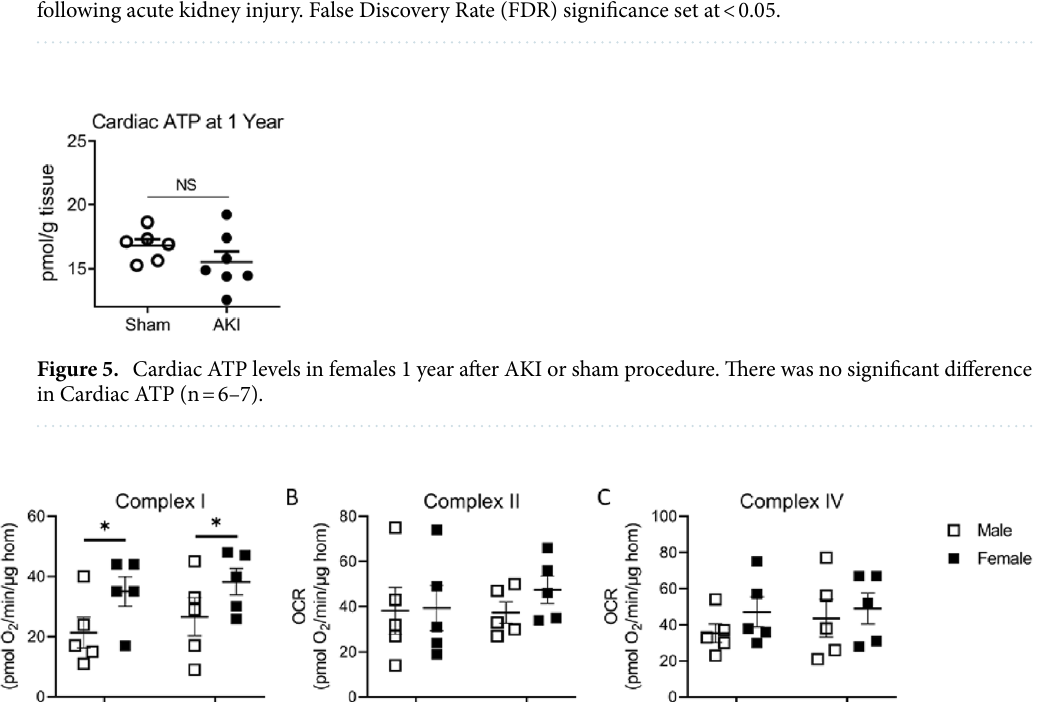
Table 2. MetaboAnalyst pathway enrichment in plasma and heart tissue. MetaboAnalyst Pathway Enrichment Analysis in plasma and heart tissue, for analytes significantly different between male versus female mice following acute kidney injury. False Discovery Rate (FDR) significance set at < 0.05.